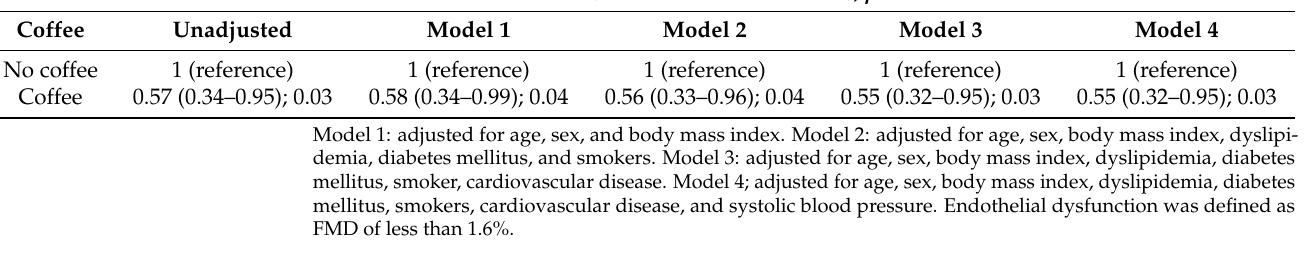
Table 3. Multivariate Analysis of Vascular Smooth Muscle Dysfunction in No Coffee and Coffee Groups. Odds ratio (95% Confidence Interval); p Table 2. Multivariate Analysis of Endothelial Dysfunction in No Coffee and Coffee Groups.